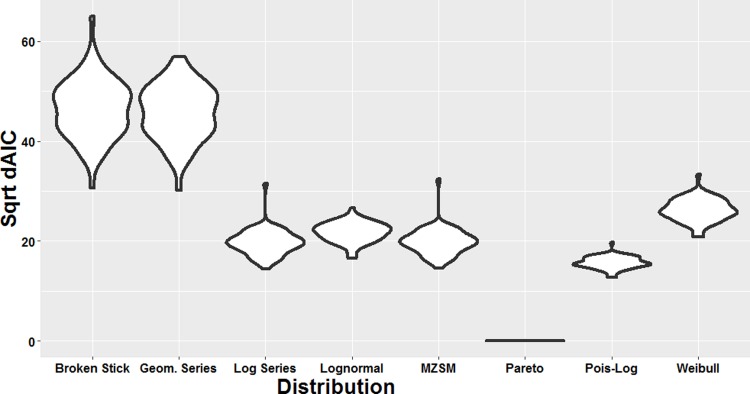
Violin plots of square root-transformed dAICc values for MLE fitted genus abundance distributions across all 60 samples.A value of 0 indicates the best-fitting distribution; higher dAICc values indicate poorer fits.